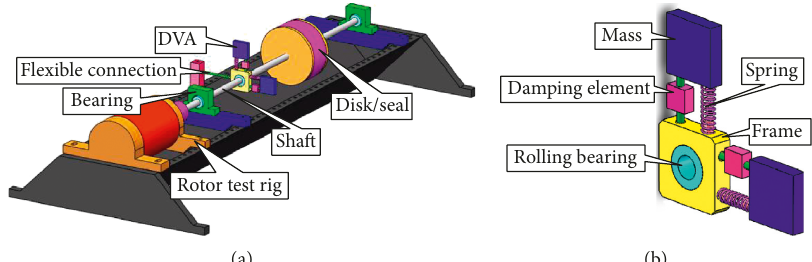
Figure 1: The schematic diagram of the structure of the rotor/seal system with the DVA. (a) The structure of the whole test rig. (b) The structure of the DVA.